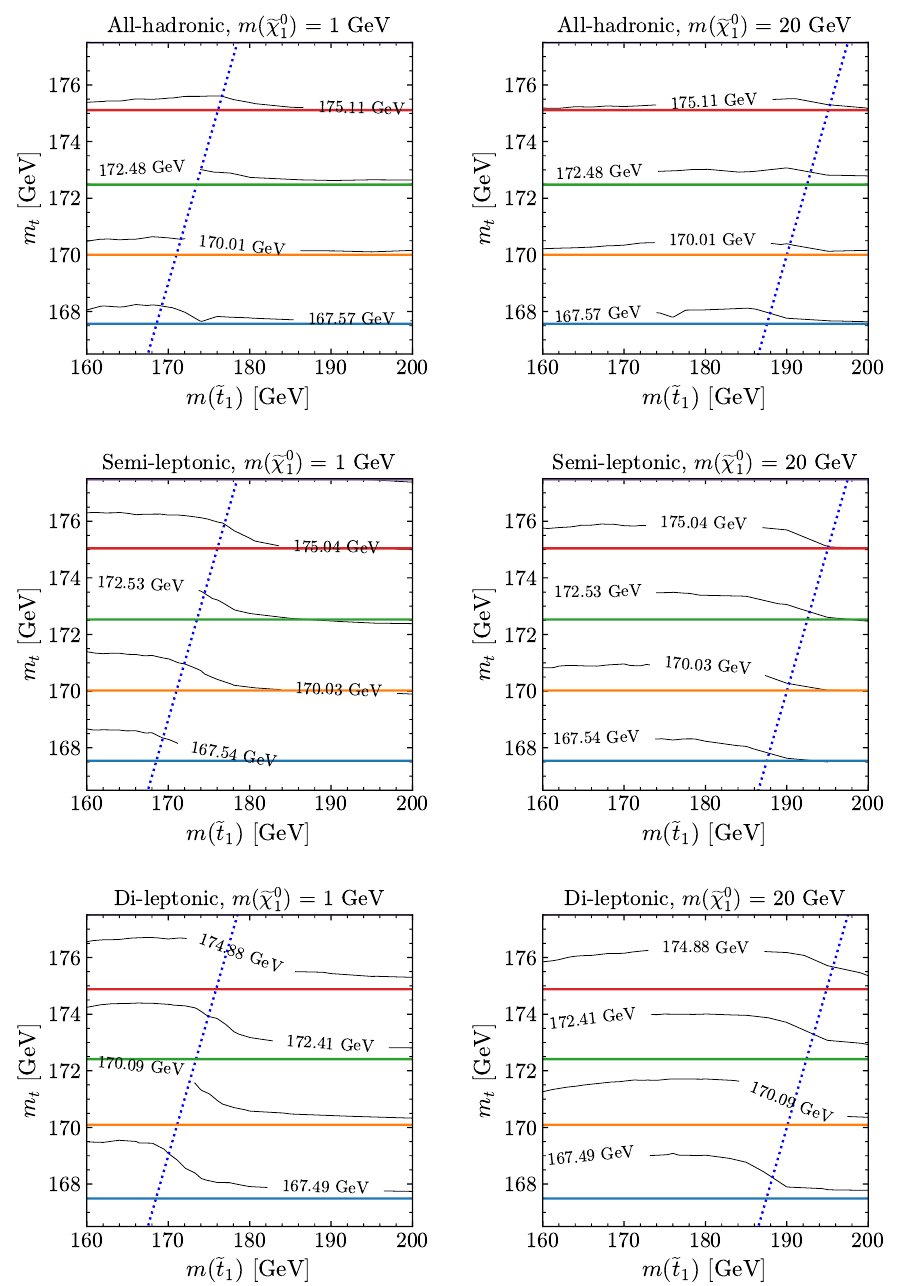
Figure 10 . E(cid:11)ects of stop contamination on m t compared to pure top simulations. The top, middle, and bottom rows correspond to the all-hadronic, semi-leptonic, and di-leptonic channels, respectively. The plots in the left column correspond to the choice m ( ~ (cid:31) 0 1 ) = 1 GeV, while those in the right column are for m ( ~ (cid:31) 0 1 ) = 20 GeV. In each panel, the colored lines represent the m t reconstructed from pure t (cid:22) t benchmark samples. The blue dotted line indicates the kinematic boundary where the tops from the stop decays start to be produced on-shell. The black curves are contours of constant reconstructed top mass when using SM only templates. The speci(cid:12)c contours are chosen to match the SM only closure